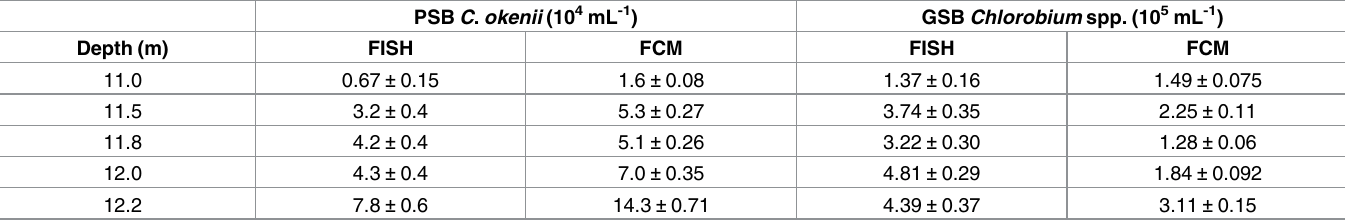
Table 1. Comparison between FISH ( ± standard error) and FCM ( ± 5%, maximal machine error) quantification of PSB C . okenii and GSB Chloro- bium spp. in the chemocline of Lake Cadagno (12 July